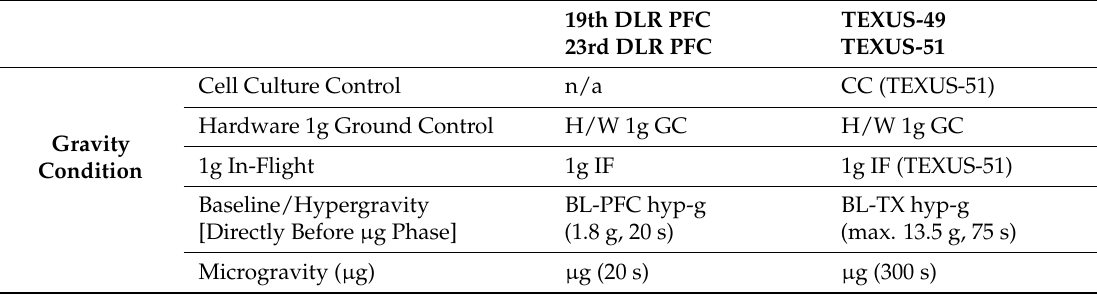
Table 1. Abbreviations of experiment groups of the 19th DLR and 23rd DLR parabolic flight campaign and TEXUS-49 and TEXUS-51 suborbital ballistic rocket campaigns. Additional information on the group is given in squared